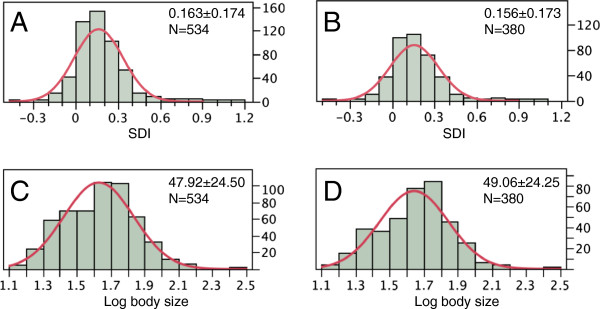
Distributions of logarithm transformed body size and sexual dimorphism index. SDI = Body-sizefemale/Body-sizemale –1. A &C. Range + mean data. B &D. Mean data only.